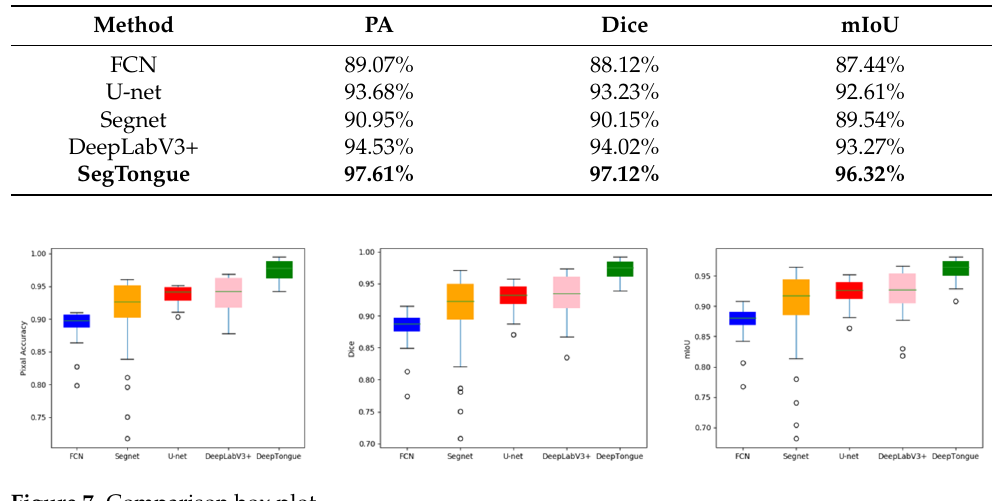
Figure 7. Comparison box plot.